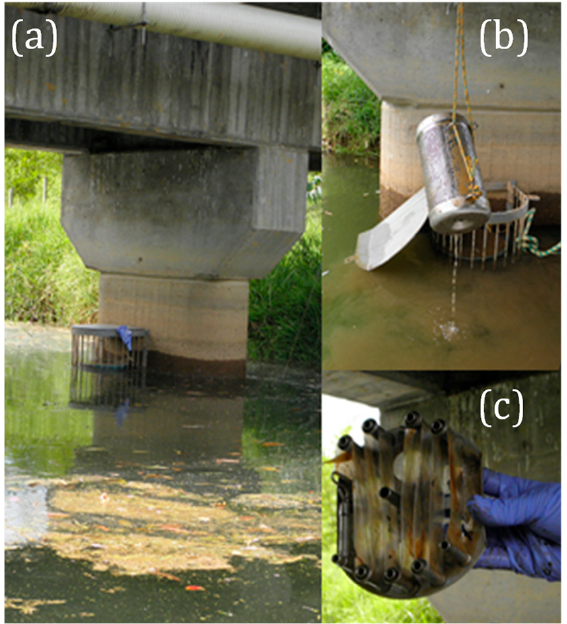
Figure 2. ( a ) The PSPT fastened to the bridge column with a protection grill, including a padlock. ( b ) Large deployment canisters. ( c ) SPMDs attached to a spider holder.